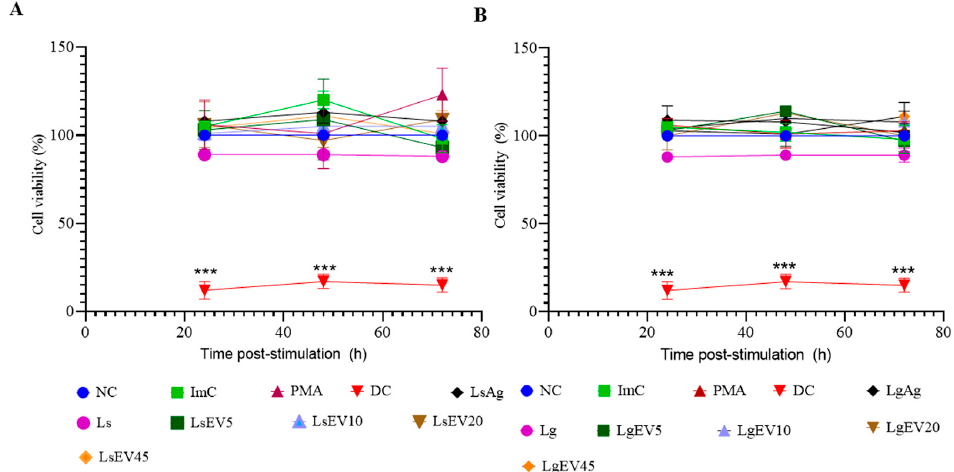
Figure 6. E ff ect of L. shawi and L. guyanensis EVs on M Ф viability. The viability of M Ф incubated for 24 h, 48 h, and 72 h with 5, 10, 20, and 45 µg·mL − 1 of EVs from L. shawi ( A ) and L. guyanensis ( B ), for 24 h, 48 h, and 72 h with 5, 10, 20, and 45 µ g · mL − 1 of EVs from L. shawi ( A ) and L. parasite antigens, and promastigotes was analyzed by resazurin reduction. NC: negative control